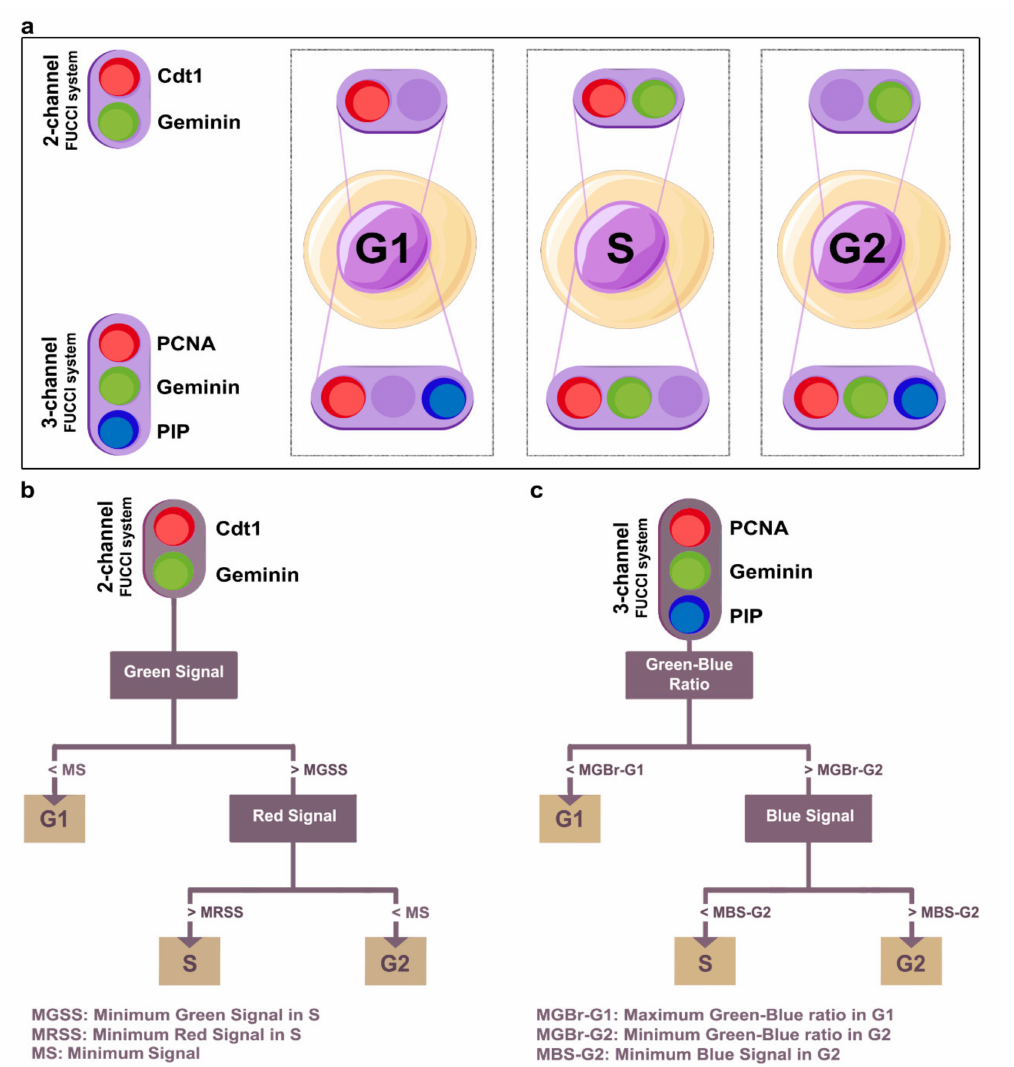
Figure 2. A description of the phase prediction methods of CellMAPtracer fluorescent ubiquitination-based cell-cycle indicator (FUCCI) plug-in. ( a ) Schematic representation of FUCCI labeling across the cell-cycle phases. ( b ) The mechanistic prediction process of the cell-cycle phase in a two-channel FUCCI system. ( c ) The mechanistic prediction process of the cell-cycle phase in a three-channel FUCCI